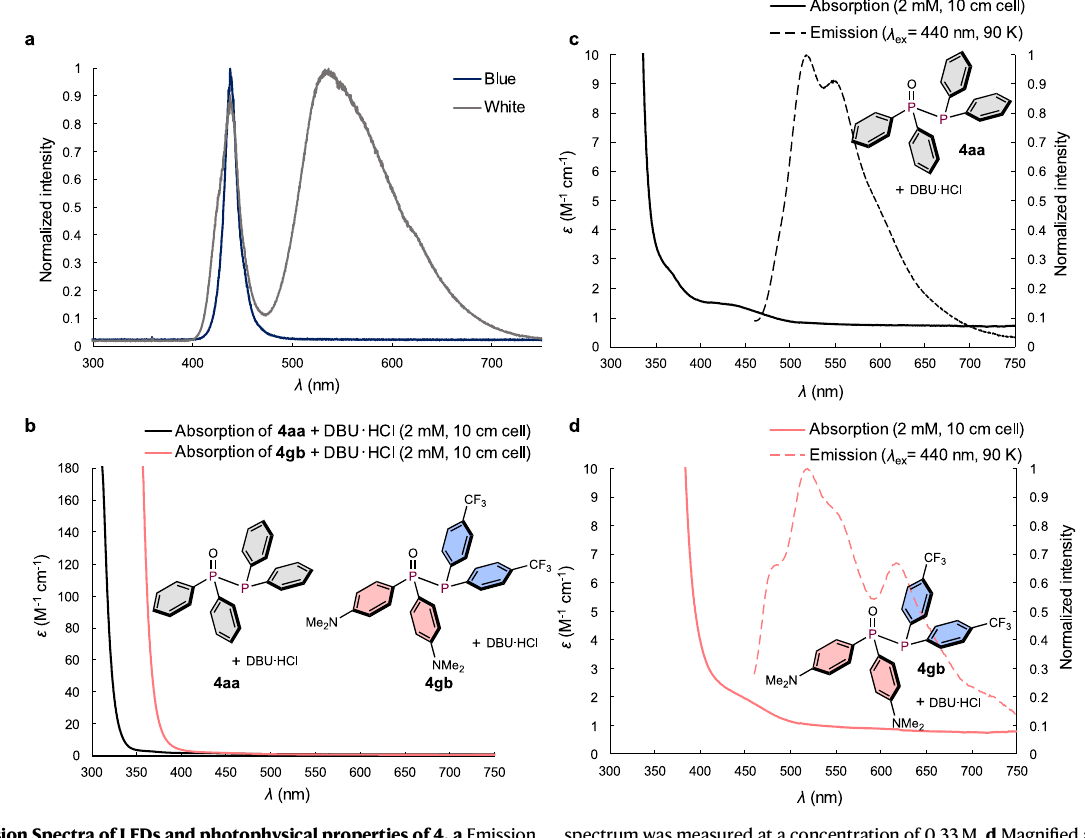
spectrum was measured at a concentration of 0.33M. d Magni fi ed absorption and emission spectra of 4gb in DCM. The emission spectrum was measured at a con- centration of